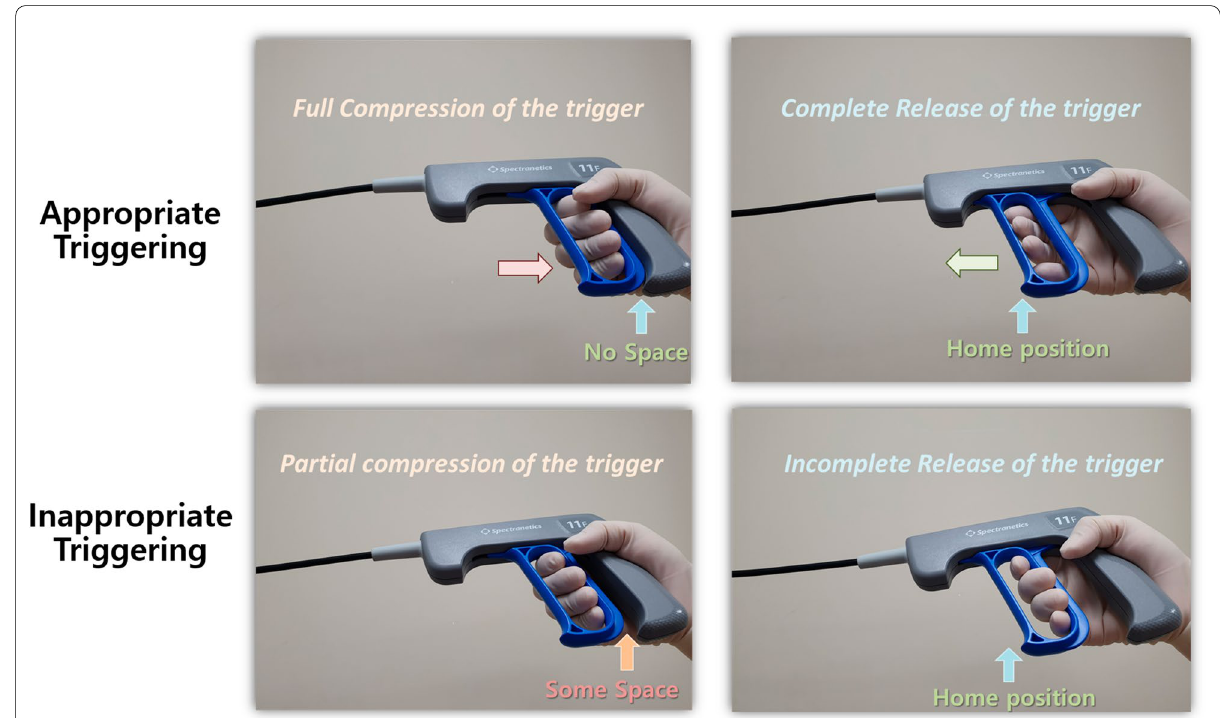
Fig. 3 Appropriate actuation of the trigger. To achieve bidirectional dissection, full compression of the trigger to the handle and complete release to its home position are